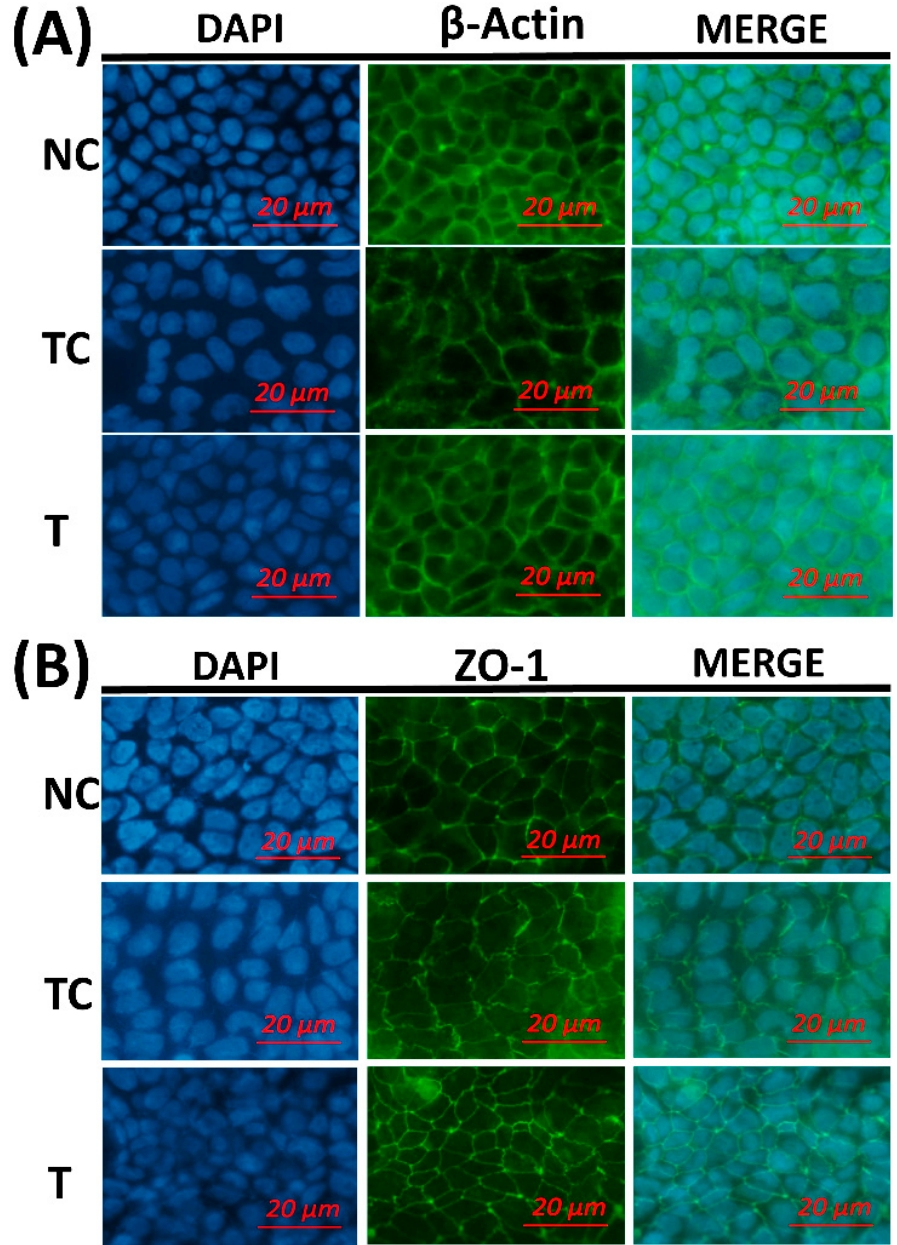
Figure 5. The e ff ect of red-osier dogwood extracts (RDE) on the morphological changes of β -actin fiber and tight junction in Caco-2 cells after H 2 O 2 treatment. ( A ) The morphological changes of β -actin and ( B ) The morphological changes of ZO-1. NC indicates negative control: cells were cultured with a medium without H 2 O 2 and RDE for 27 h (3 h + 24 h). TC indicates treatment control: cells were cultured with a medium containing 1 mM of H 2 O 2 for 3 h, and then treated with a medium for 24 h. T indicates RDE treatment: cells were cultured with a medium containing 1 mM of H 2 O 2 for 3 h, and then treated with medium containing 100 µ g / mL of RDE for 24 h. ZO-1: zonula